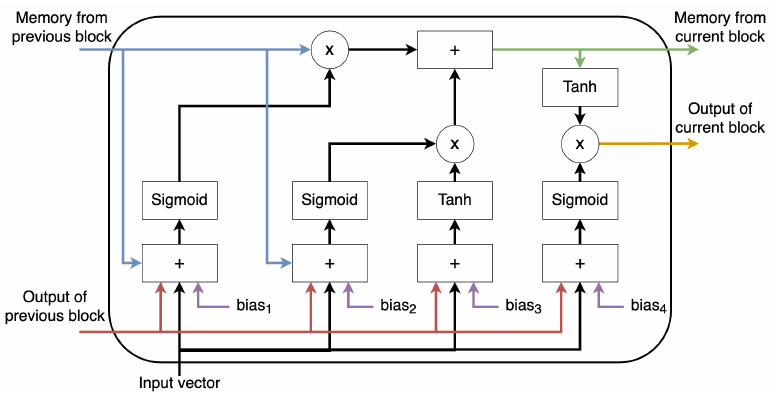
Figure 3. Elementary building block of the LSTM